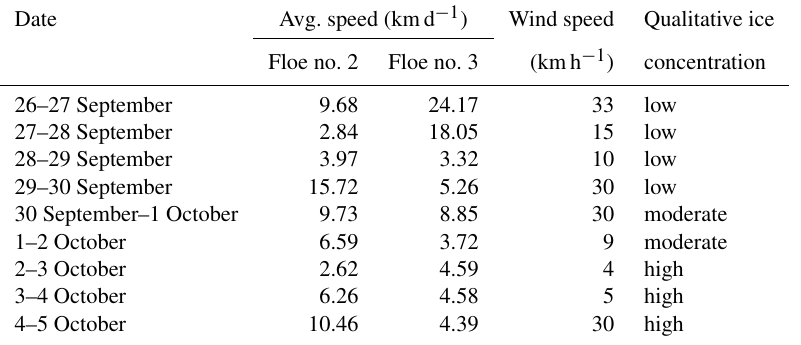
Table 2. Drift speed of ice floe no. 2 and no. 3 (shown in Fig. 8) during the period between the acquisitions of the two successive daily Sentinel-1 images. The period is shown in the first column.